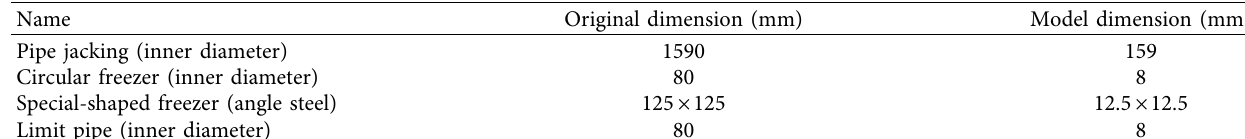
Table 1: Dimensions of jacking pipe and freezers.